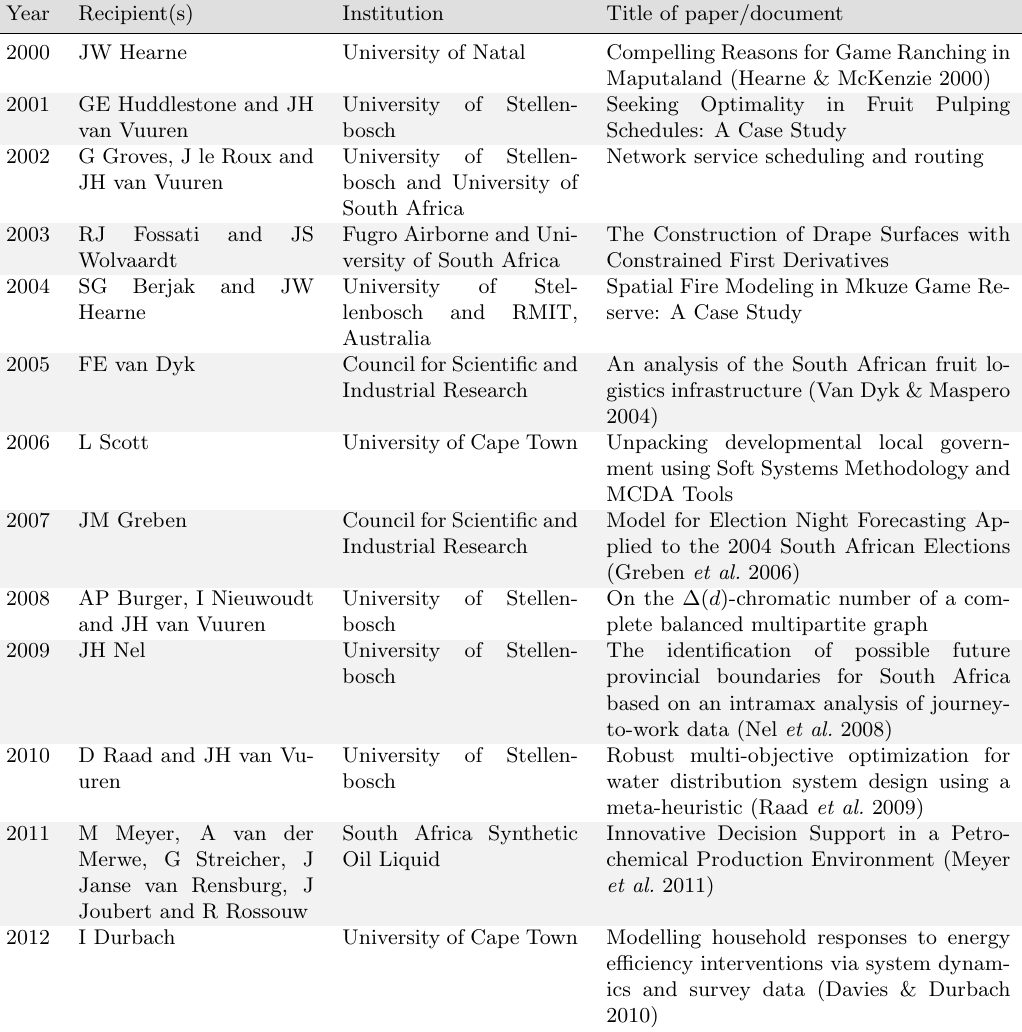
Table 2: A list of TR medal recipients from